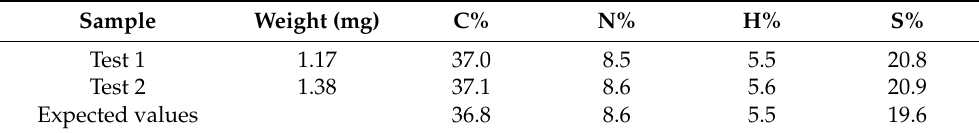
Figure 5. The HPLC analysis of purified N -acetylcysteine molecule.